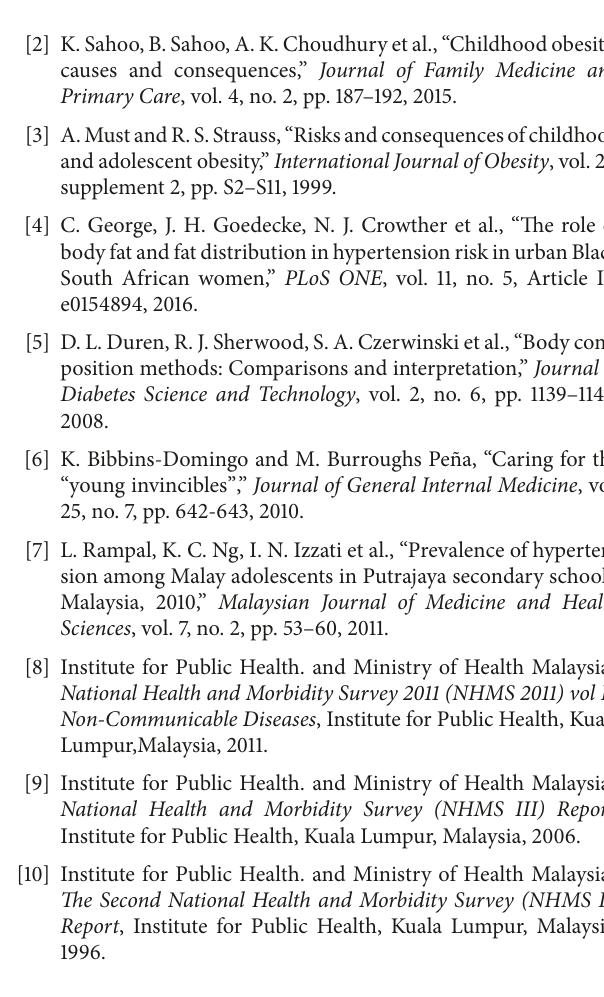
for boys and 20.7 kg/m 2 for girls was recommended for BMI, and a cutoff point of 67.1 cm for boys and 68.2 cm for girls was recommended for WC to detect elevated blood